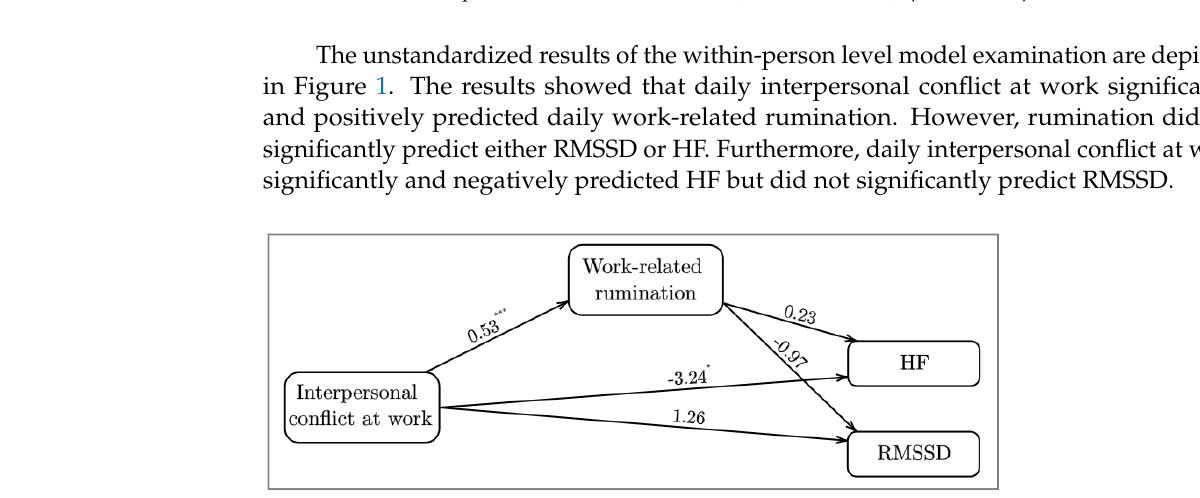
Figure 1. Unstandardized estimates and p − values of day − level estimates of the direct effects. * p ≤ 0.05. *** p ≤